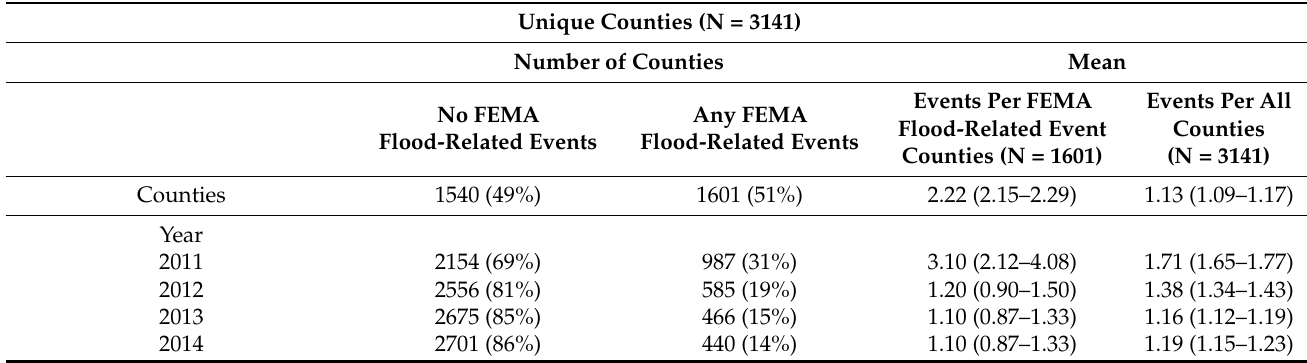
Table 2. FEMA Event and No-FEMA Event Counties and Events Rates,